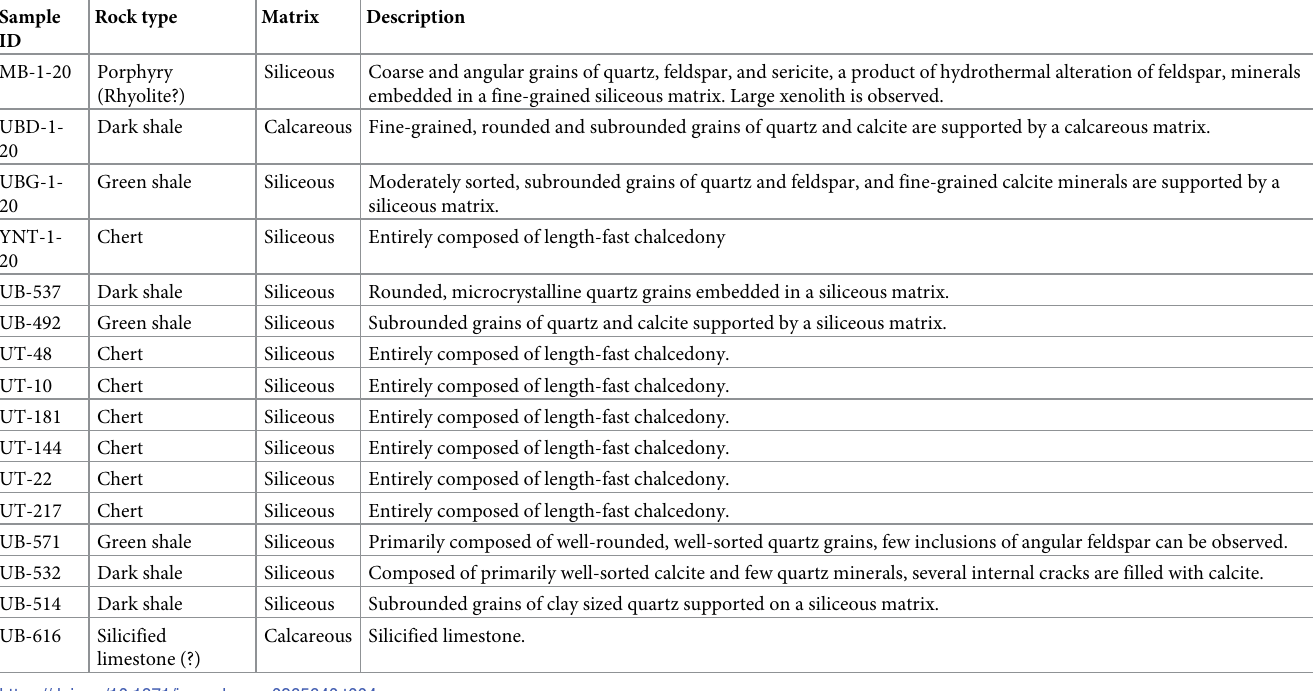
Table 4. Basic petrographic description of archaeological and geological thin